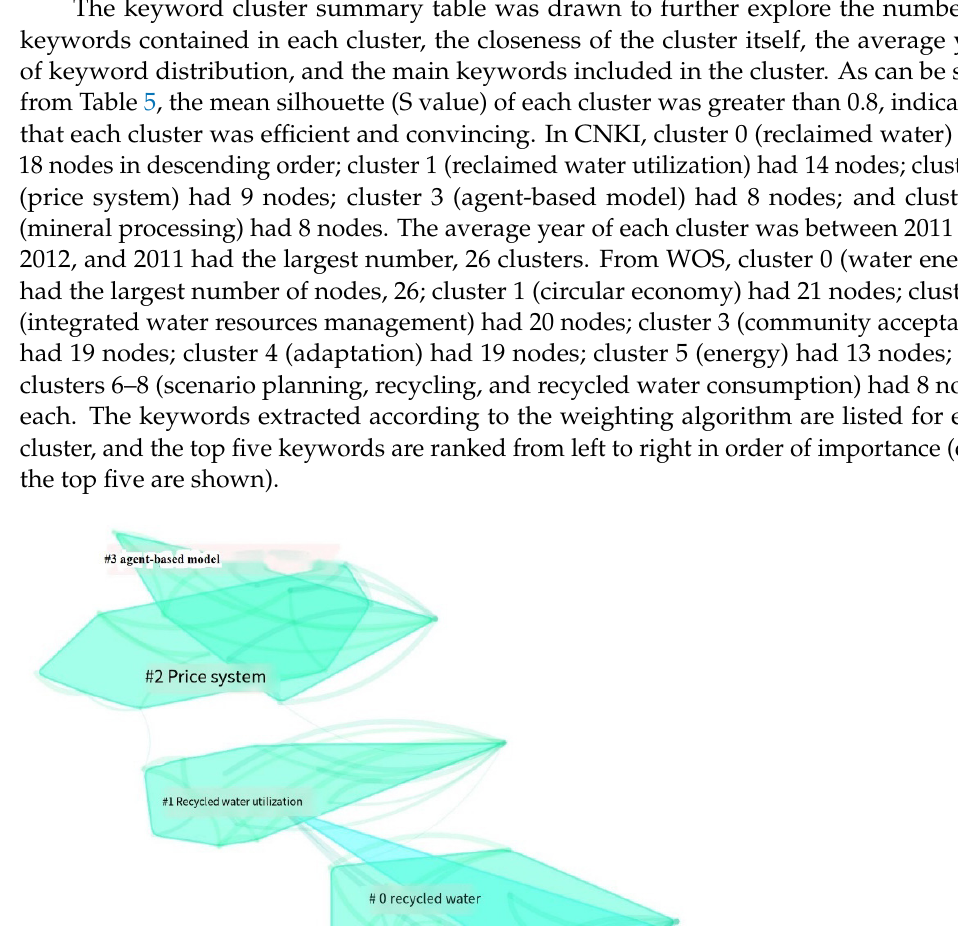
. Figure 11. WOS keyword clustering. The keyword cluster summary table was drawn to further explore the number of keywords contained in each cluster, the closeness of the cluster itself, the average year of keyword distribution, and the main keywords included in the cluster. As can be seen from Table 5, the mean silhouette (S value) of each cluster was greater than 0.8, indicating